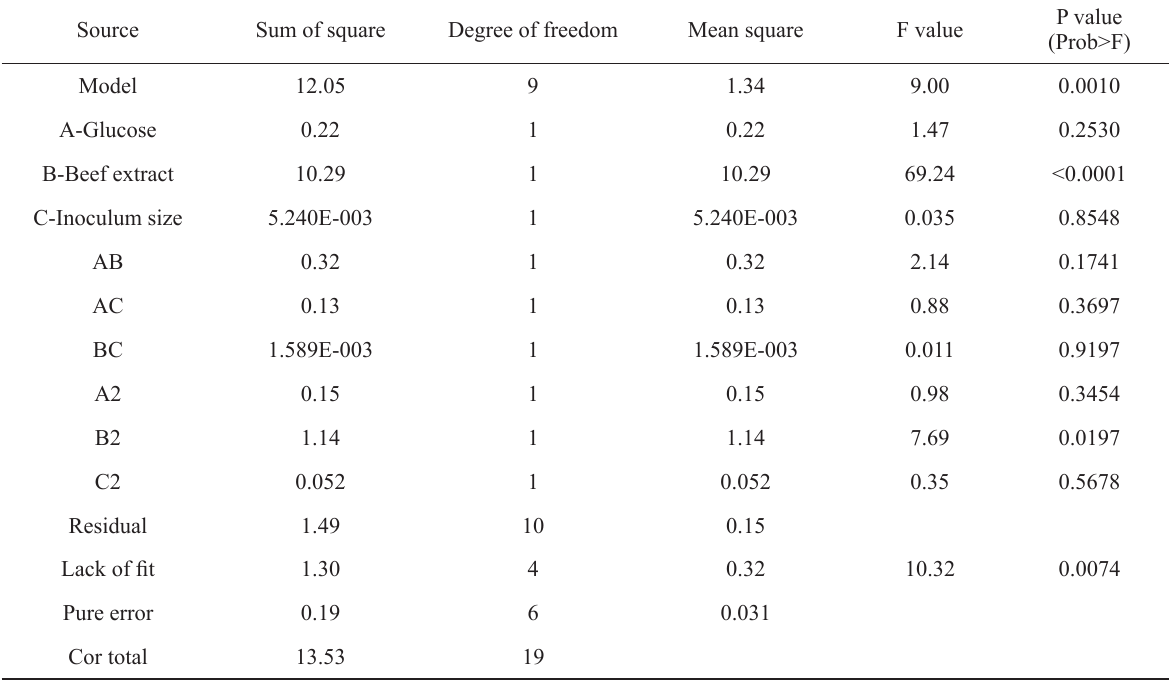
ANOVA for quadratic model showing interaction between three variables.